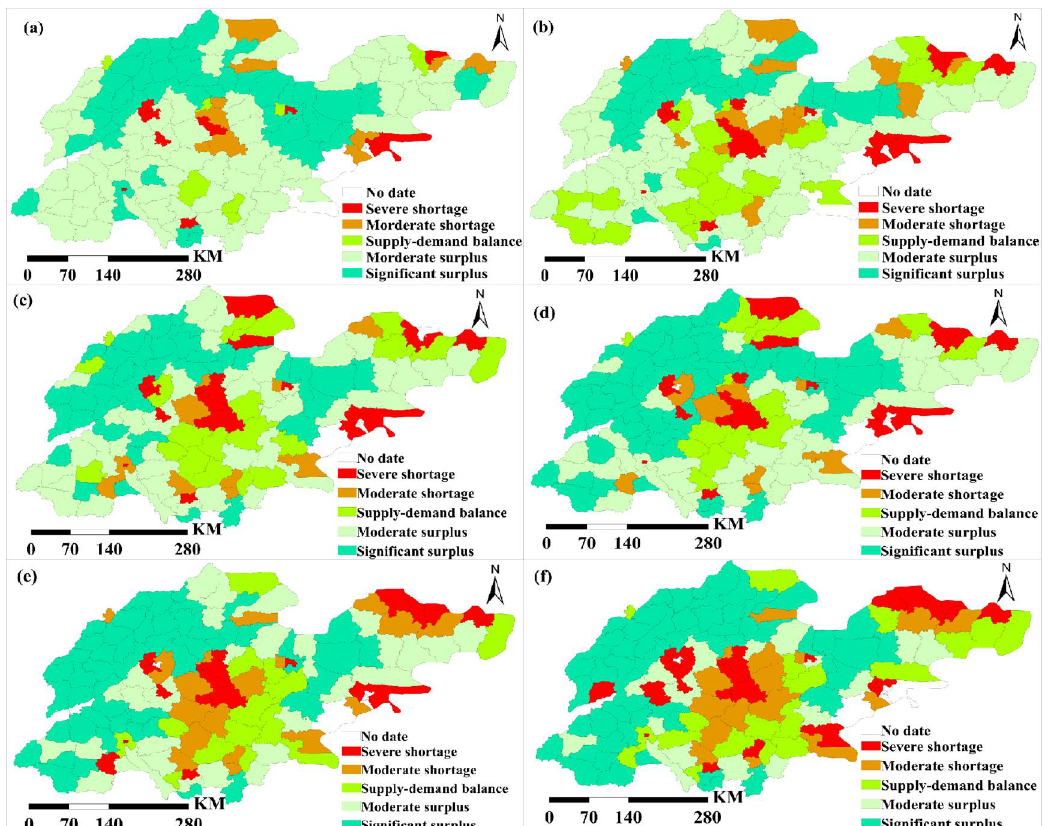
Figure 3. Spatial pattern of county level grain supply in 1995 ( a ), 2000 ( b ), 2005 ( c ), 2010 ( d ), 2015 ( e ), and 2020 ( f ).